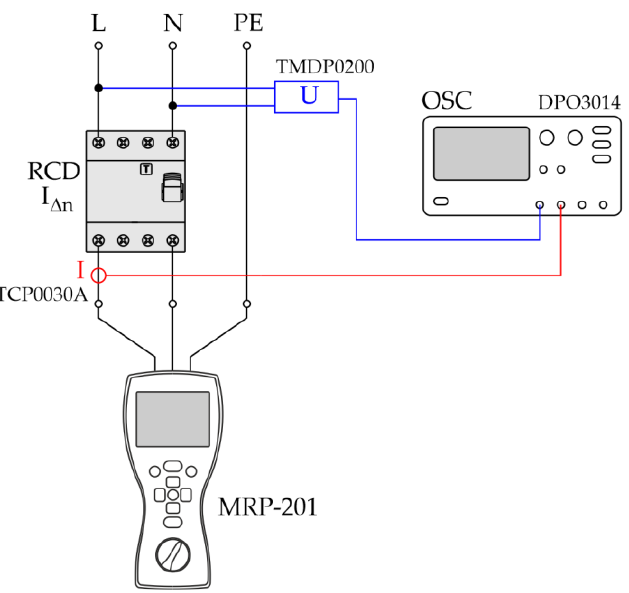
Figure 5. Diagram of the system for measuring the break times and tripping currents of RCDs using the MRP-201 meter from SONEL. the MRP-201 meter from